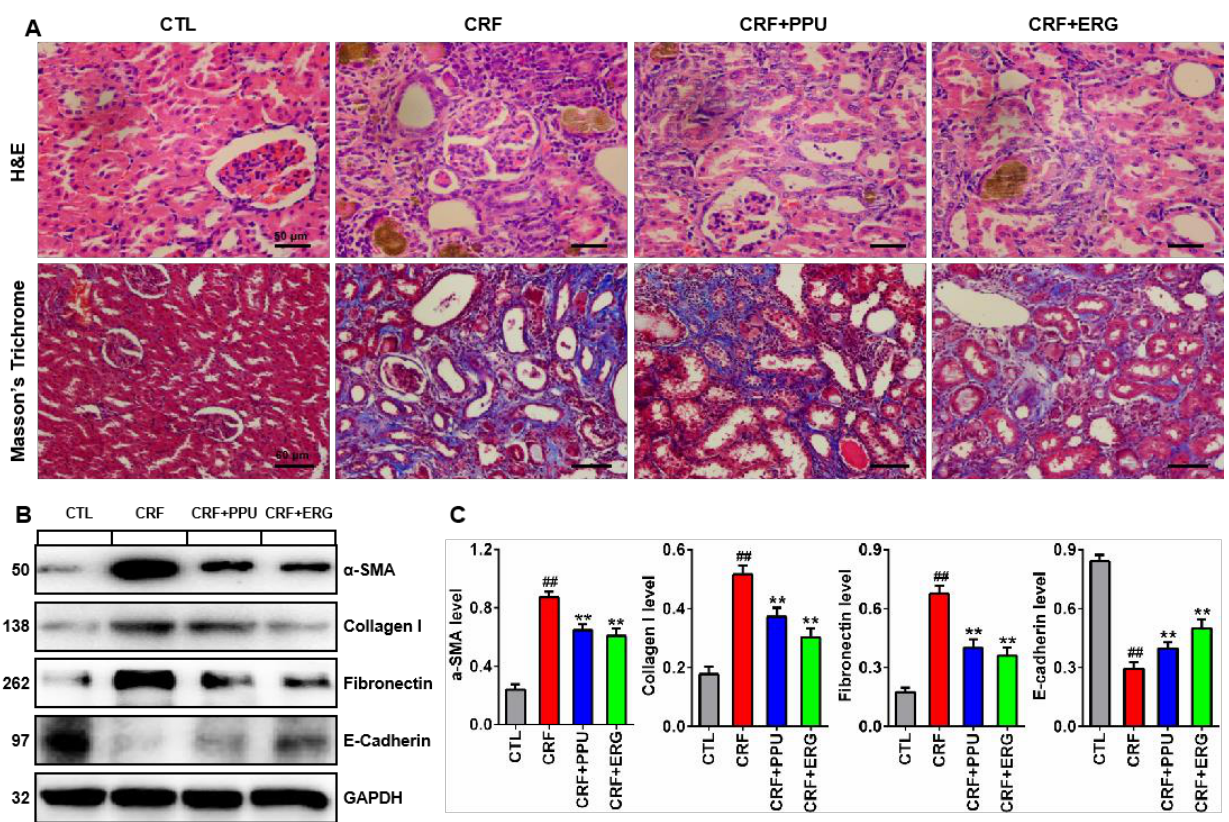
Figure 5. Treatment with PPU and ERG ameliorated renal fibrosis in adenine-induced CRF rats. ( A ) Histological findings of kidney tissues of hematoxylin & eosin (H&E) and Masson’s trichrome staining from control, CRF, CRF+PPU and CRF+ERG rats. H&E, scale bar, 50 μ m; Masson’s trichrome staining, scale bar, 60 μ m. ( B ) Protein expression of α-SMA, collagen I, Fibronectin, and E-cadherin in kidney tissues of control, CRF, CRF+PPU, and CRF+ERG rats. ( C ) Quantitative analysis of α-SMA, collagen I, Fibronectin, and E-cadherin in kidney tissues of control, CRF, CRF+PPU, and CRF+ERG rats. ## — p < 0.01 compared with CTL rats; ** p < 0.01 com- pared with CRF rats.